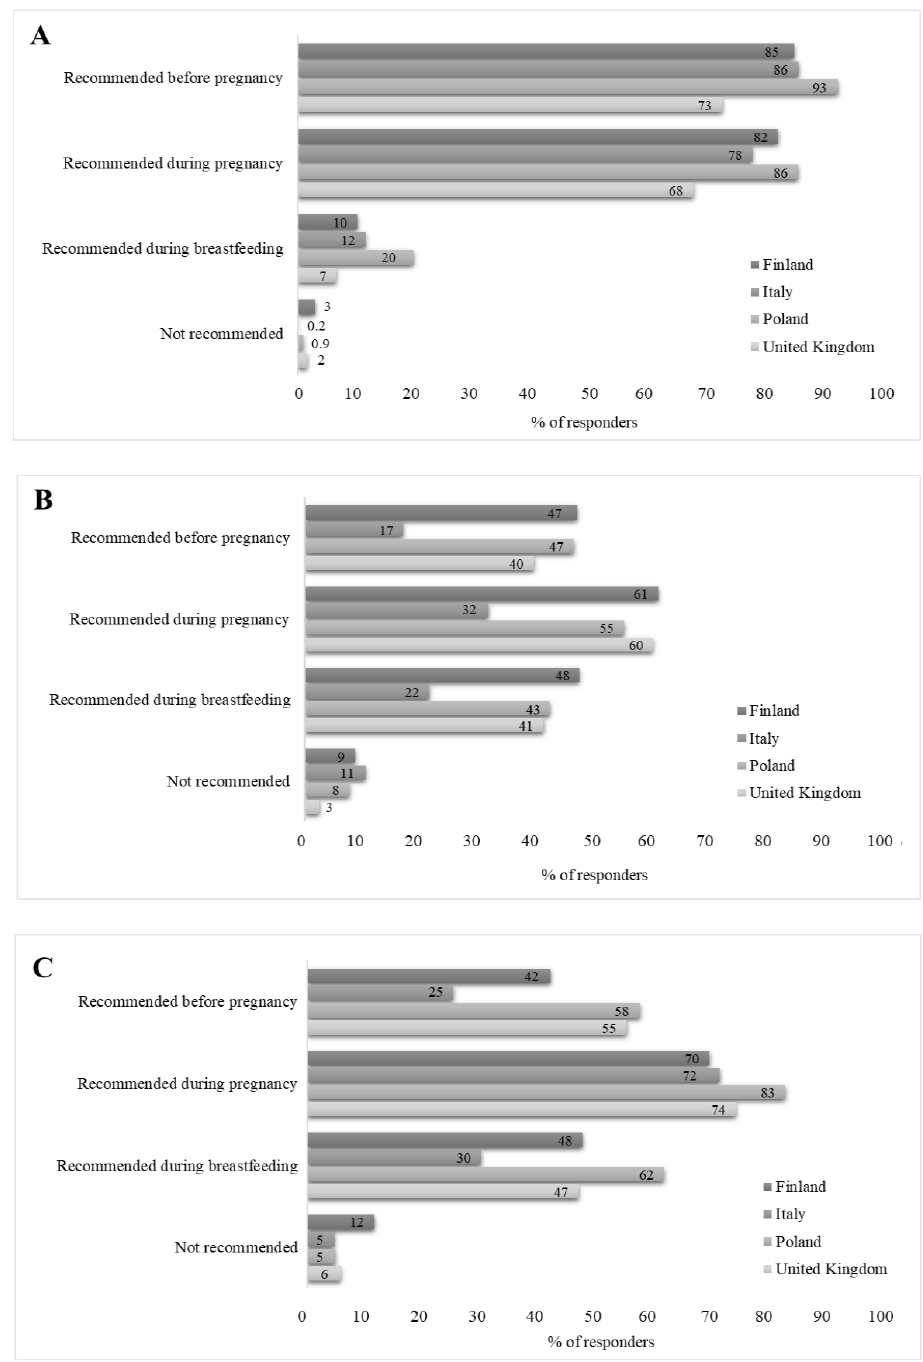
Figure 2. Proportion of participants reporting in an online survey that specific supplements are rec- ommended for use before and during pregnancy and during breastfeeding by country of residence: ( A ) folic acid; ( B ) vitamin D; ( C ) multivitamin supplement. Finland, n = 536; Italy, n = 540; Poland, n = 585; the United Kingdom, n = 121.